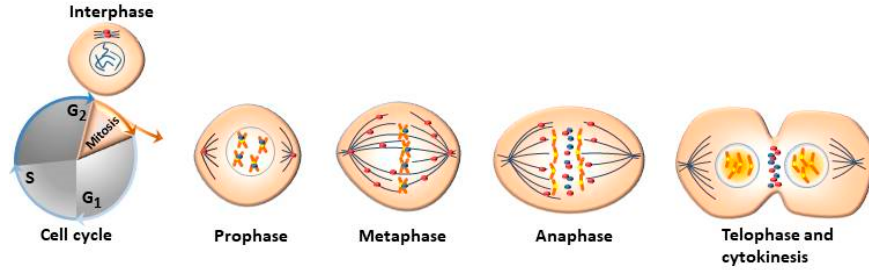
Figure 1. The Aurora kinases, AURKA ( Figure 1. The Aurora kinases, AURKA ( ) and AURKB ( ) are expressed ) and AURKB ( Figure 1. The Aurora kinases, AURKA ( ) and AURKB ( ) are expressed ) are expressed and activated from Figure 1. The Aurora kinases, AURKA ( ) and AURKB ( ) are expressed and activated from the G2 and activated from the G2 through the M phase being involved in mitotic chromosomal segregation and activated from the G2 through the M phase being involved in mitotic chromosomal segregation the G2 through the M phase being involved in mitotic chromosomal segregation [13,14]. AURKA is through the M phase being involved in mitotic chromosomal segregation [13,14]. AURKA is mainly [13,14]. AURKA is mainly localized in the centrosomes in interphase and mitotic cells, and is [13,14]. AURKA is mainly localized in the centrosomes in interphase and mitotic cells, and is mainly localized in the centrosomes in interphase and mitotic cells, and is important for centrosome localized in the centrosomes in interphase and mitotic cells, and is important for centrosome i mportant for centrosome maturation and separation, which in turn are necessary for mitotic important for centrosome maturation and separation, which in turn are necessary for mitotic maturation and separation, which in turn are necessary for mitotic entry and bipolar spindle formation. maturation and separation, which in turn are necessary for mitotic entry and bipolar spindle entry and bipolar spindle formation. AURKB is generally located at the kinetochore of mitotic entry and bipolar spindle formation. AURKB is generally located at the kinetochore of mitotic AURKB is generally located at the kinetochore of mitotic cells and to the midbody of cytokinetic cells, formation. AURKB is generally located at the kinetochore of mitotic cells and to the midbody of cells and to the midbody of cytokinetic cells, which regulate kinetochore-microtubule which regulate kinetochore-microtubule attachments that are critical for chromosome alignment and cells and to the midbody of cytokinetic cells, which regulate kinetochore-microtubule cytokinetic cells, which regulate kinetochore-microtubule attachments that are critical for attachments that are critical for chromosome alignment and segregation as well as to segregation as well as to regulate cytokinesis [31,32]. AURKB and AURKC are thought to have the attachments that are critical for chromosome alignment and segregation as well as to chromosome alignment and segregation as well as to regulate cytokinesis [31,32]. AURKB and regulate cytokinesis [31,32]. AURKB and same distribution pattern in mitotic cells [33], hence, AURKC is not included in the regulate cytokinesis [31,32]. AURKB and